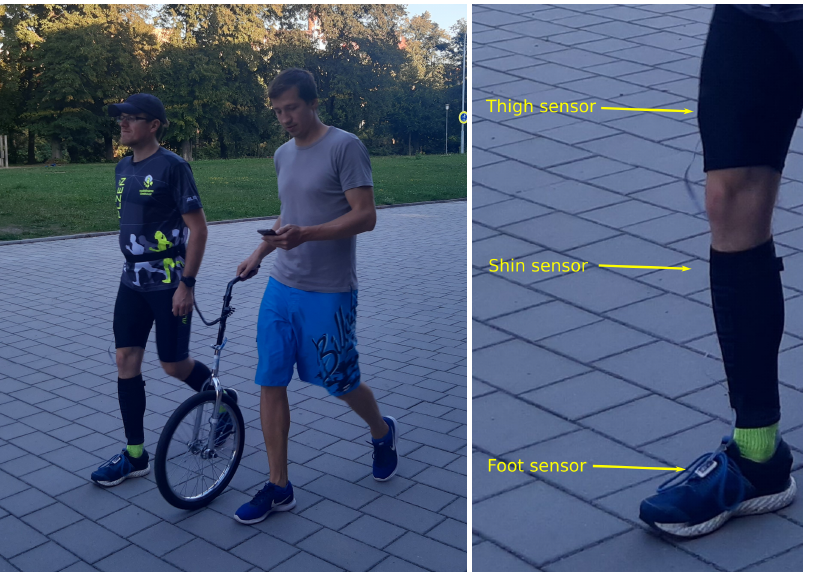
Figure 1. Illustration of the data acquisition procedure. ( Left ): collection of the IMU data and the reference mono-wheel data. ( Right ): details of the positioning of the IMU sensors on the leg. Collected